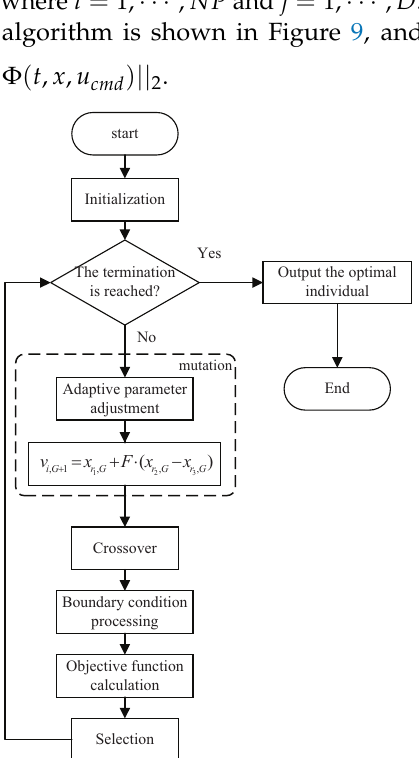
Figure 9. The workflow of adaptive differential evolution